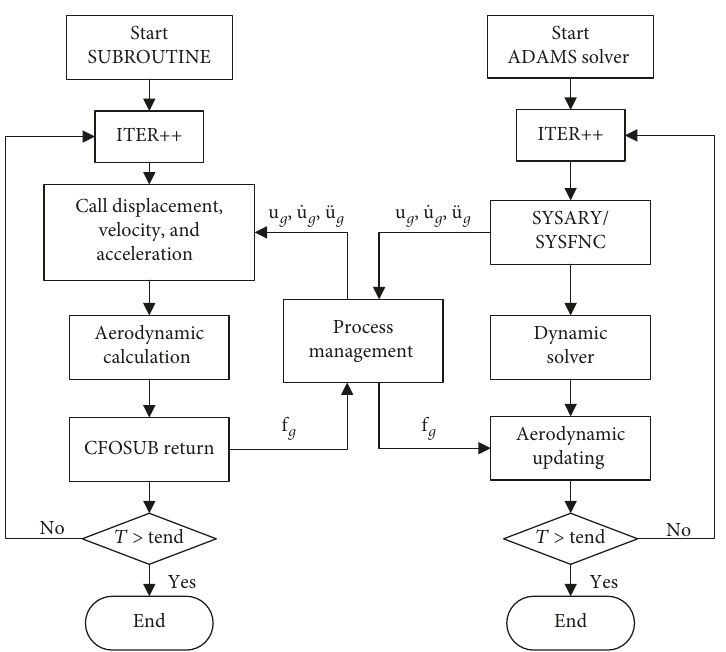
Figure 4: Flowchart of the aerodynamic